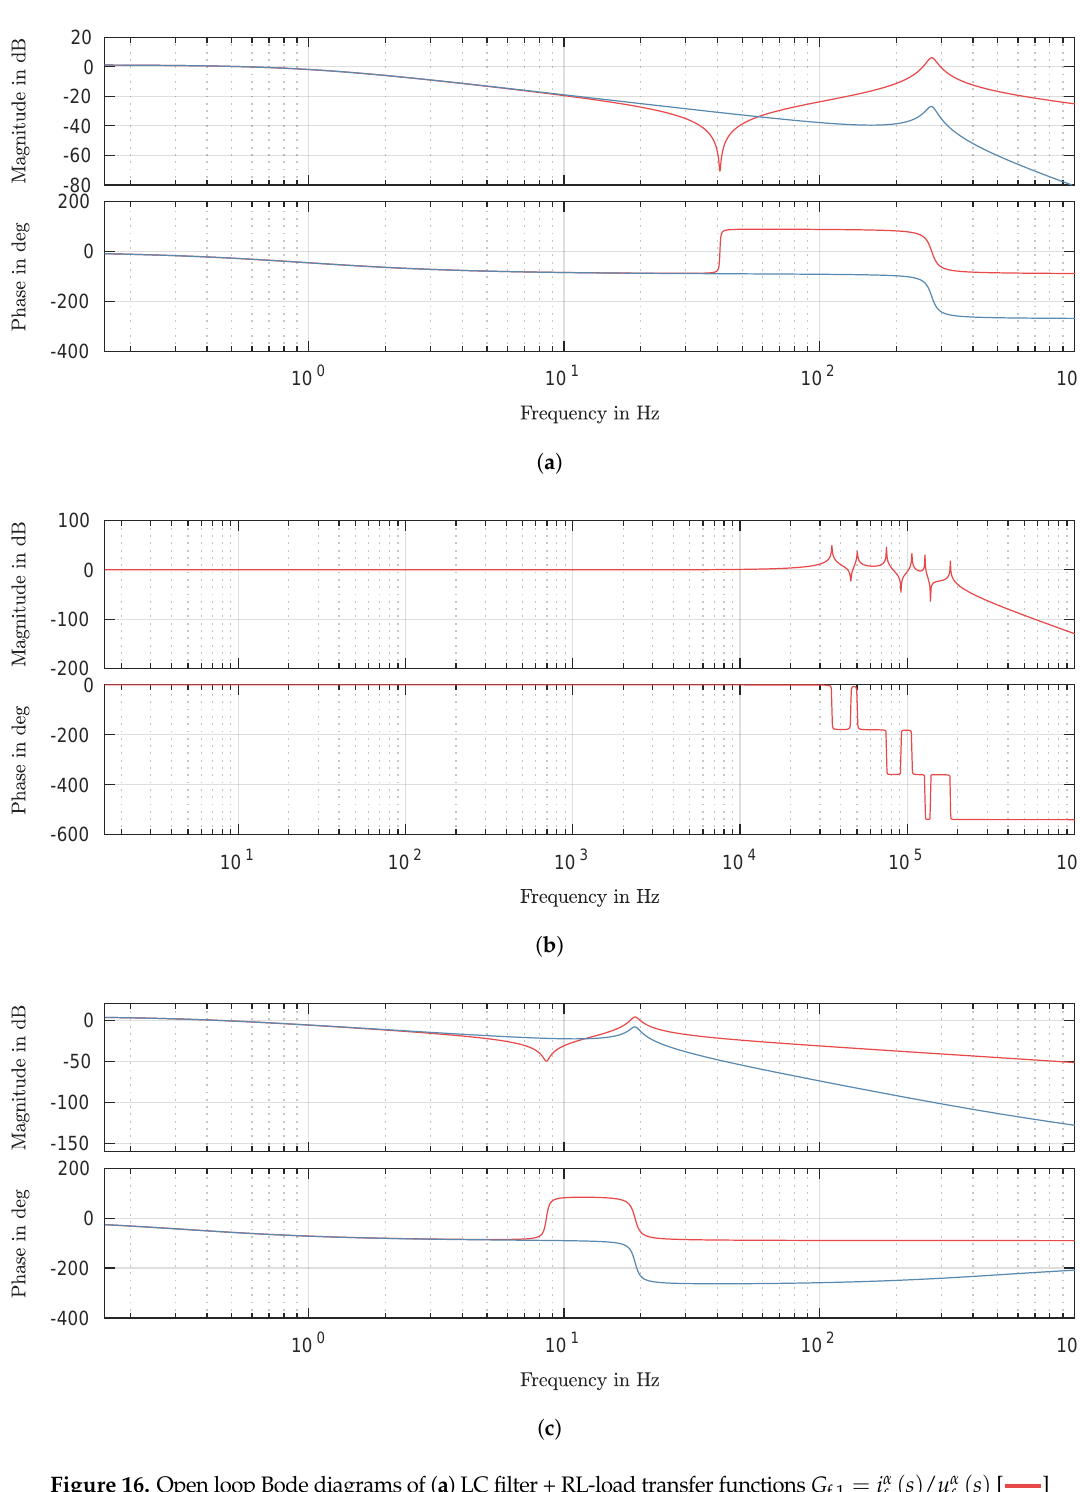
Figure 16. Open loop Bode diagrams of ( a ) LC filter + RL-load transfer functions G f,1 = i α ( s ) [ ]; ( b ) cable transfer function G c ( s ) = u α and G f,2 = i α s ( s ) / u α f 1 system transfer functions G m,1 ( s ) = ω m ( s ) / m e ( s ) [ ] and G m,1 ( s ) = ω p ( s ) / m e ( s ) [